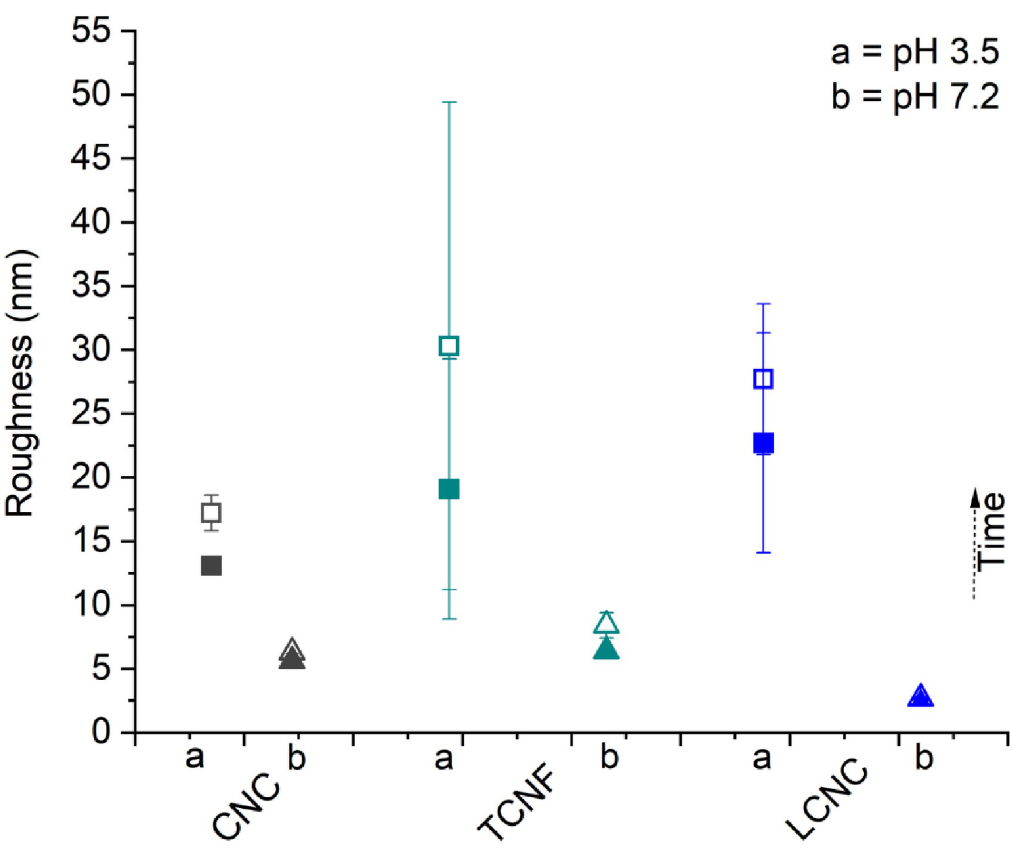
Fig 5. Comparison of the roughness values of the nanocellulose surfaces obtained at pH 3.5 and 7.2 as a function of immersion